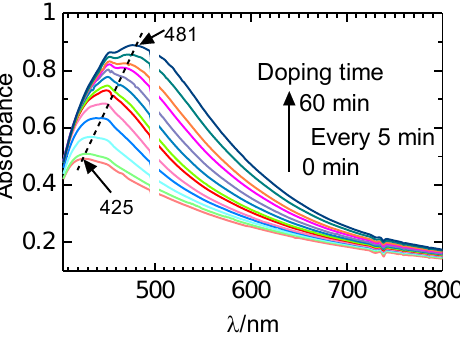
Figure 12. Change in the optical absorption of poly(Ac–Pyr) after gas-phase iodine doping at 5-min intervals.